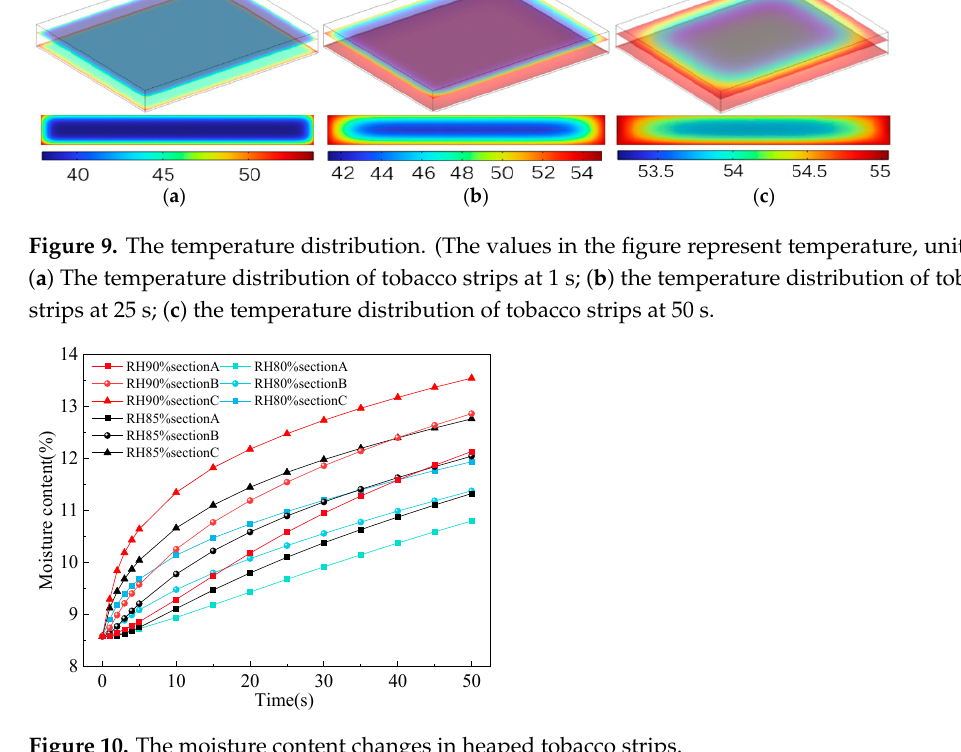
Figure 9. The temperature distribution. (The values in the figure represent temperature, unit: °C) ( a ) The temperature distribution of tobacco strips at 1 s; ( b ) the temperature distribution of tobacco strips at 25 s; ( c ) the temperature distribution of tobacco strips at 50 s.